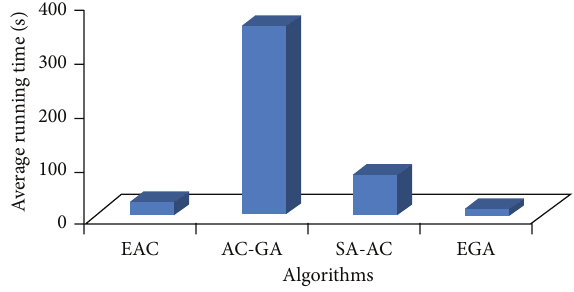
Figure 20: Comparison of average running time on map